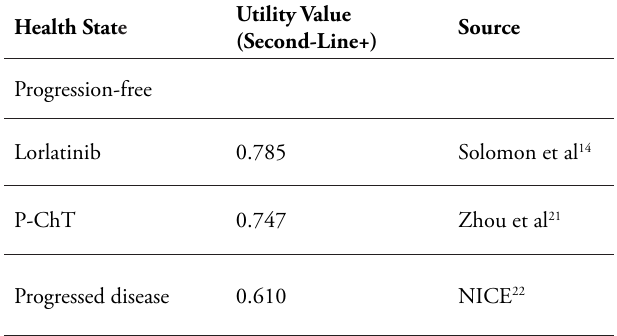
Table 1. Utility Values Considered in the